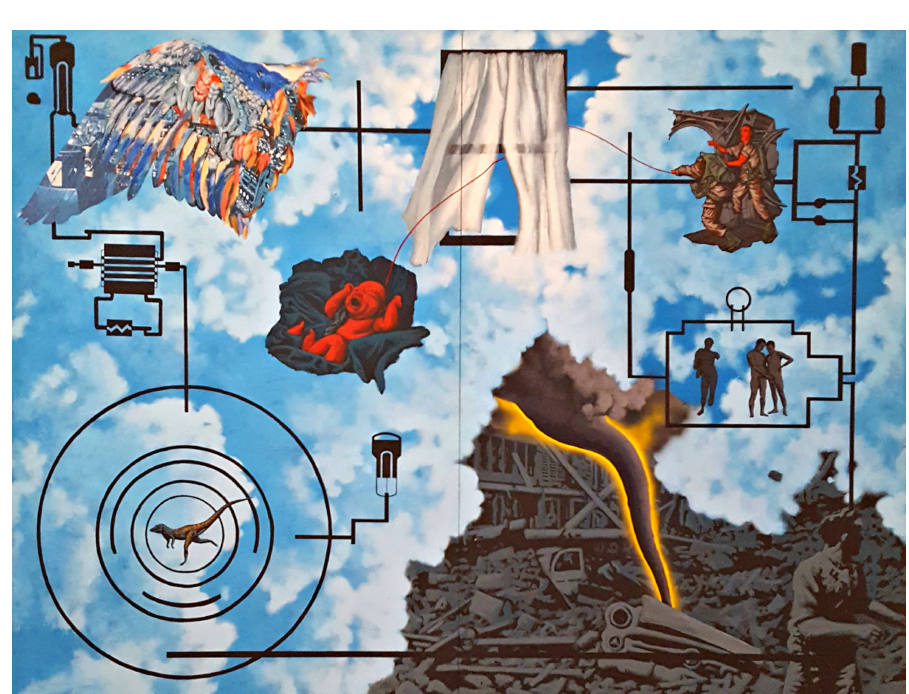
Figure 4: Wind (for Peter Hujar) , David Wojnarowicz, 1987, Acrylic and collage on wood. Photo by Paul R. Abramson